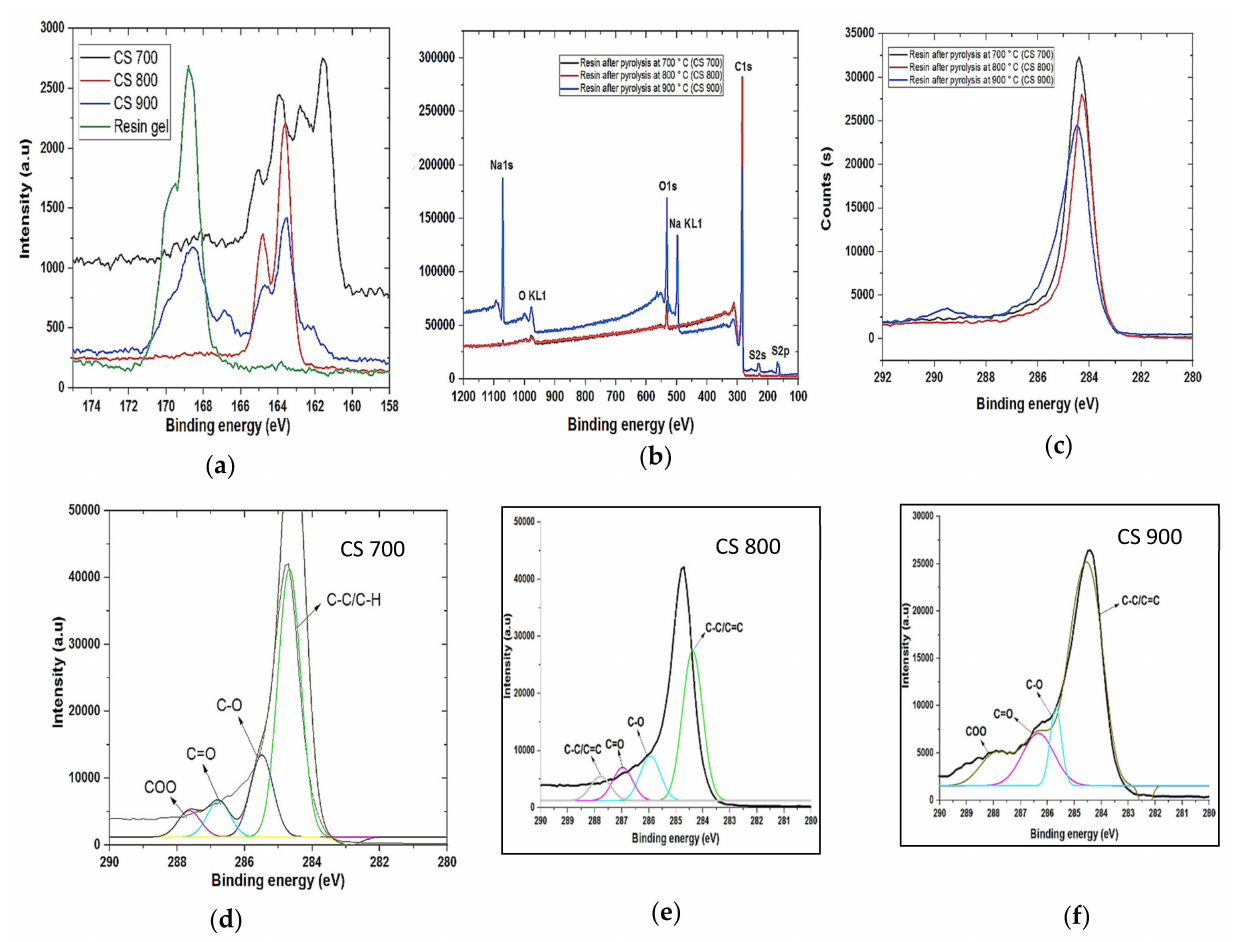
Figure 3. Sulphur 2p spectra of ( a ) resin gel, CS 700, CS 800, and CS 900; ( b ) Whole XPS spectra of CS 700, CS 800, and CS 900; ( c ) C1s spectra of CS 700, CS 800, and CS 900. ( d – f ) Deconvoluted C1s spectra of CS 700, CS 800, and CS